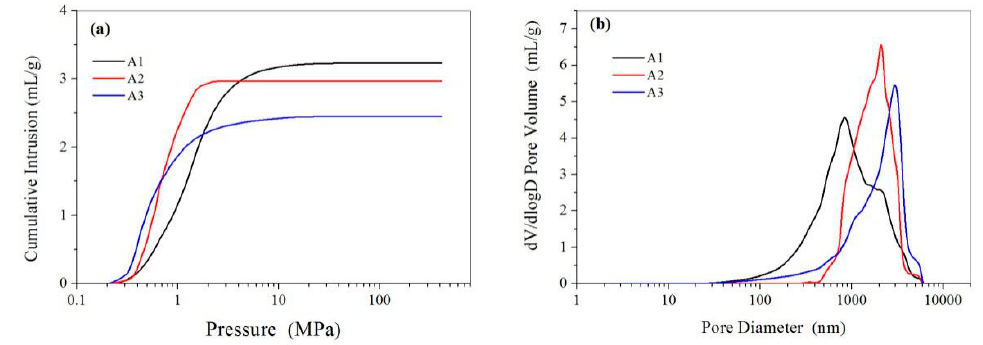
Figure 6. ( a ) Cumulative mercury intrusion traces and ( b ) pore size distribution of the CMC/CA microspheres fabricated with 2% (A1), 3% (A2), 4% (A3) CMC concentration.